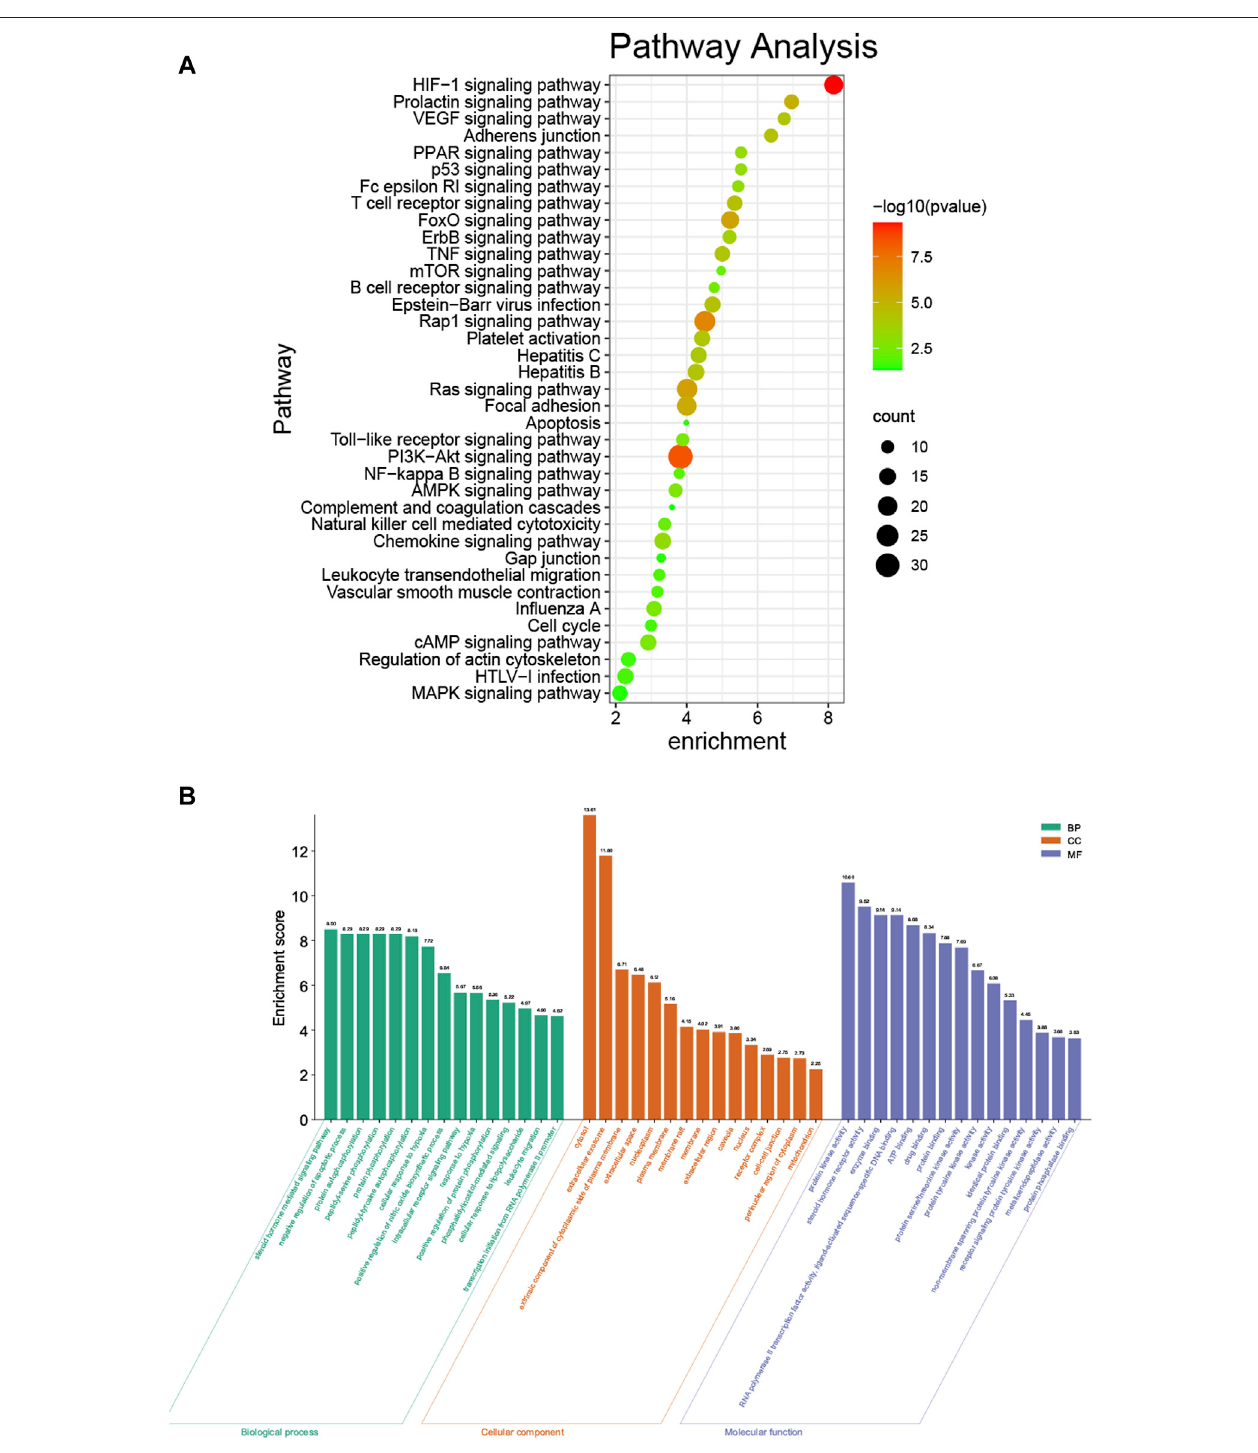
FIGURE 3 | KEGG and GO enrichment analysis. (A) KEGG enrichment analysis bubble chart by DAVID. (B) GO enrichment analysis by DAVID.